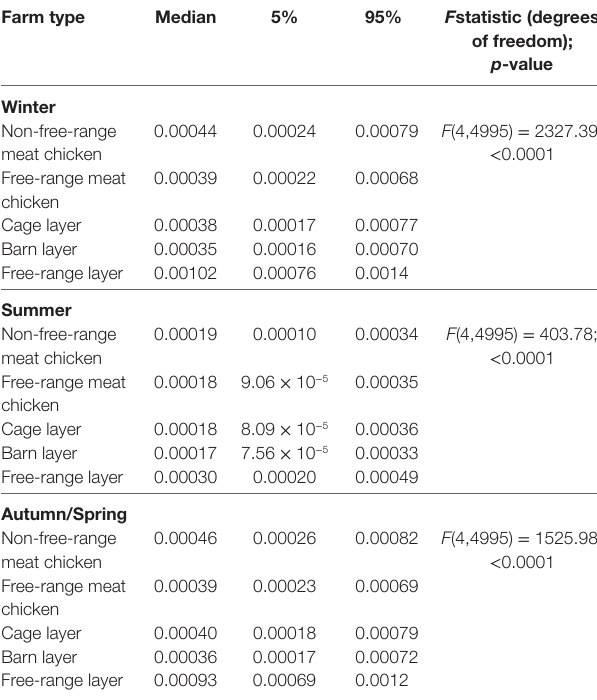
TaBle 8 | Median (5 and 95 percentiles) overall probabilities of exposure (direct and indirect) of a chicken on the commercial chicken farm types (non-free-range meat chicken, free-range meat chicken, cage layer, barn layer, free-range layer) to low pathogenic avian influenza (LPAI) viruses for the first time at any point in time during the three defined seasons; winter (June–August); summer (December–February); and autumn and spring (March–May and